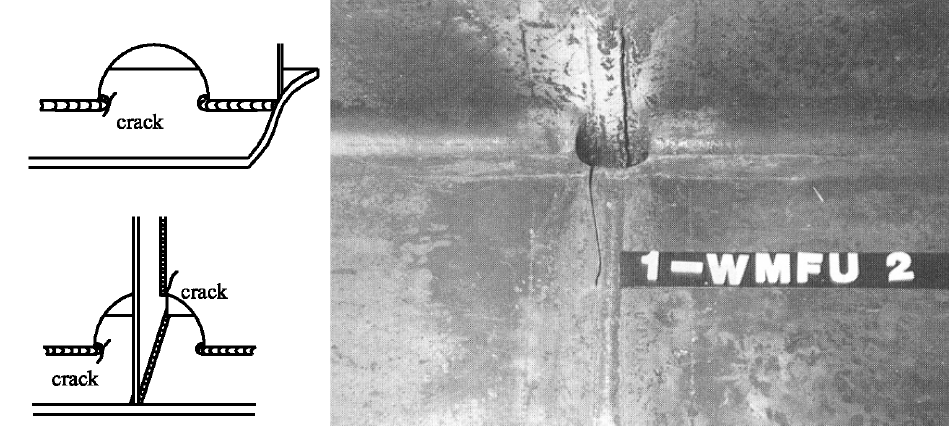
Figure 22. Examples of fatigue cracking in bridge girders with cope-holes at severe stress concentration locations